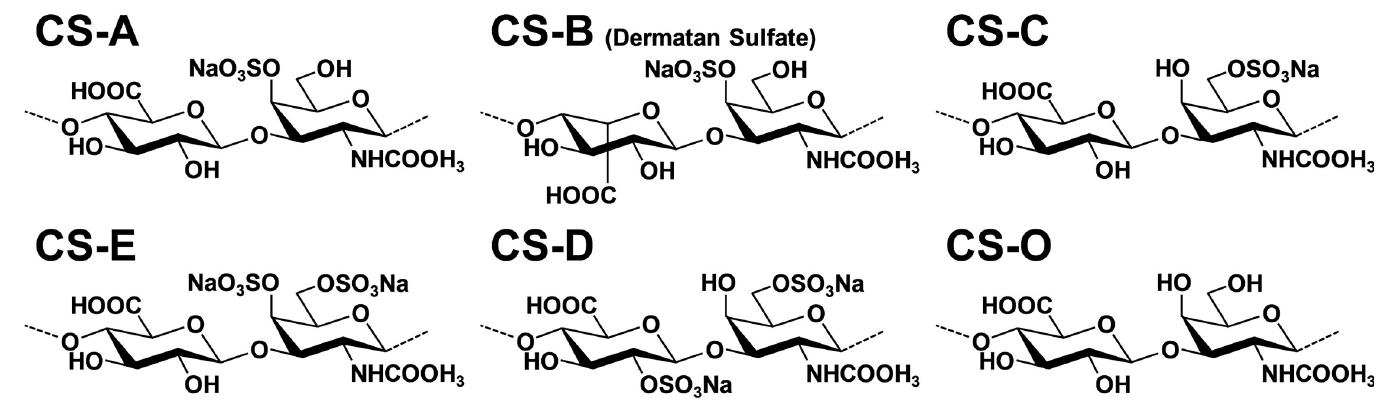
Fig 1. Molecular structure of CS (sodium salt) structural isomer